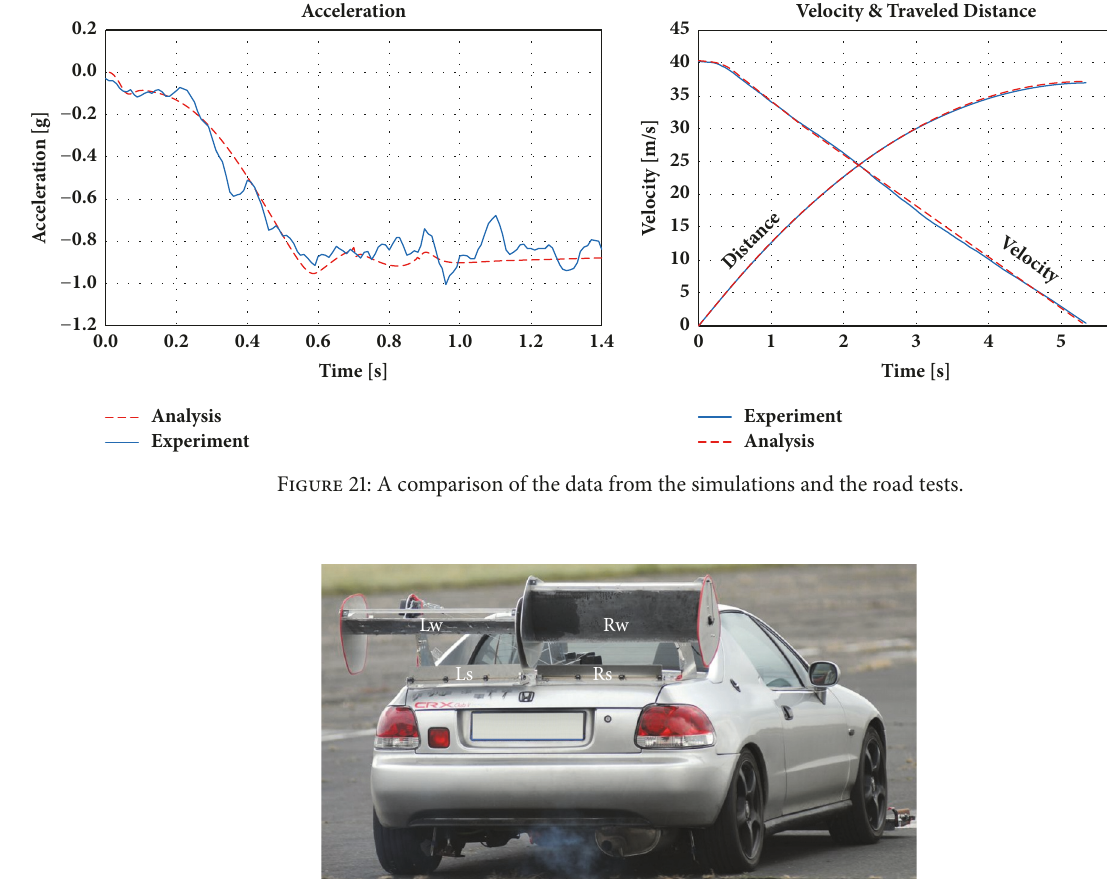
Figure 22: Snapshot from a test drive with the active aerodynamics deployed, where Lw/Rw – active left/right wing, Ls/Rs – active left/right